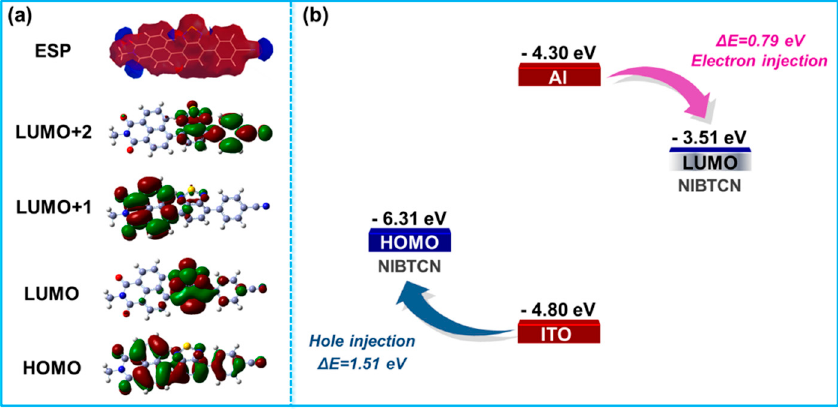
Figure 4. ( a ) DFT simulated molecular electrostatic potential (ESP), HOMO, LUMO, LUMO+1, and LUMO+2 of NIBTCN. ( b ) The energy levels of HOMO/LUMO and the work functions of ITO/Al electrodes.